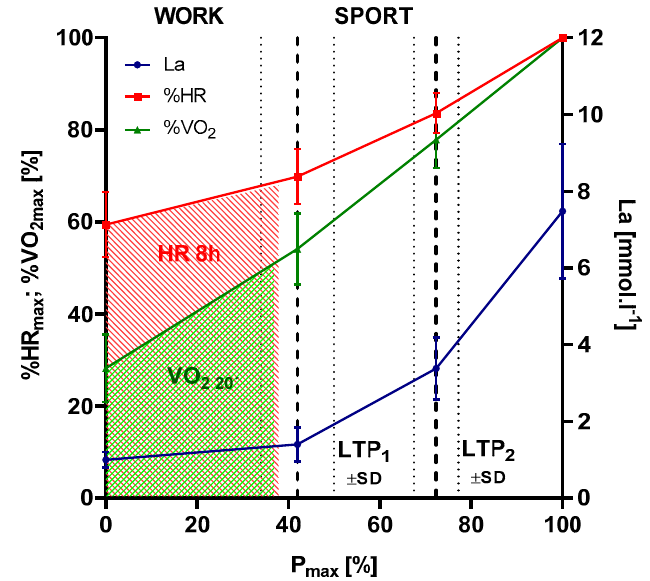
Figure 4. Eight-hour average heart rate (HR, shaded red) and 20-min representative oxygen uptake (VO 2 , shaded green) during 8 h of occupational work related to HR and VO 2 from incremental cycle ergometer exercise. Phases of metabolism are divided by lactate turn points (LTP 1 , LTP 2 ) according to Hofmann et al. [29]. Workloads below LTP 1 represent occupational work, intensities above LTP 1 represent sport activities (N = 240).